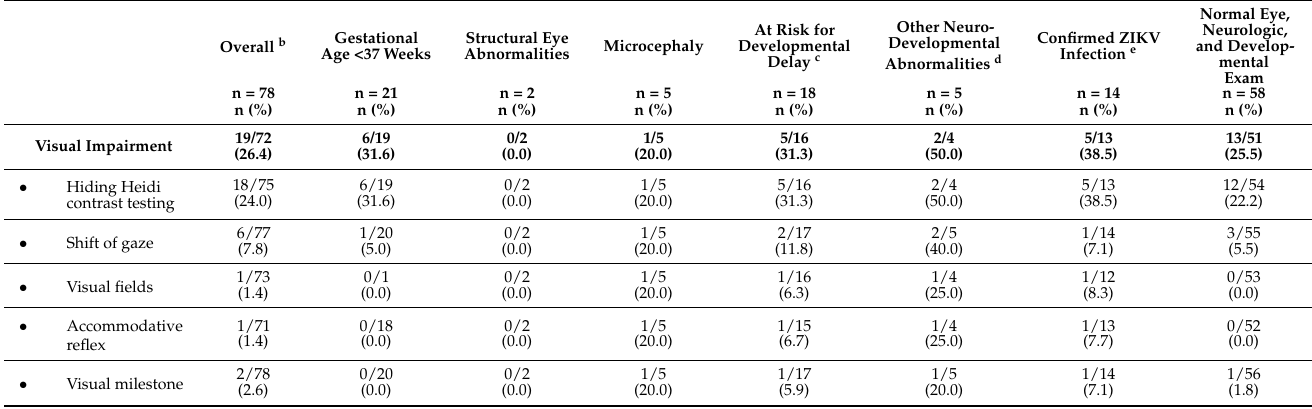
Table 3. Proportion of children with visual impairment, overall and by gestational age and other clinical characteristics a . Overall b Gestational Age <37 Weeks Structural Eye Abnormalities Microcephaly